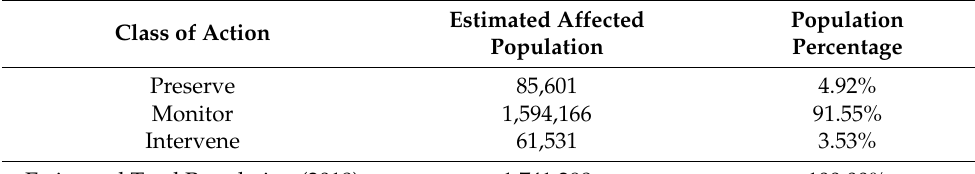
Table 17. Distribution of affected population per IUHI class of action.